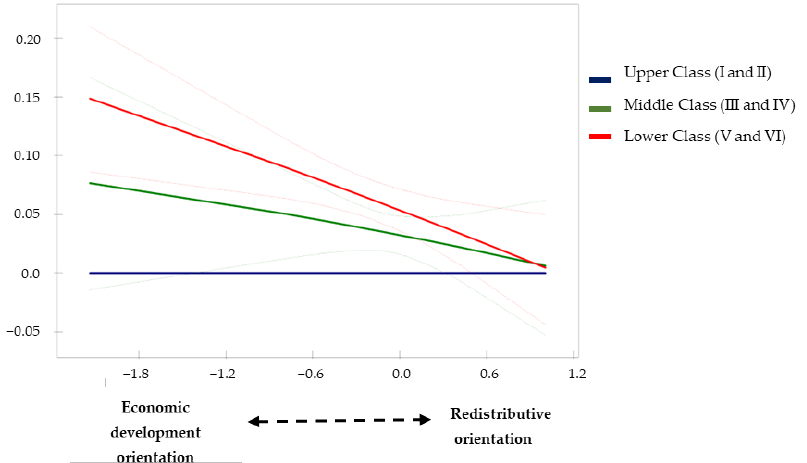
Figure 2. Differences in the activity limitations due to health problems compared with Upper Class